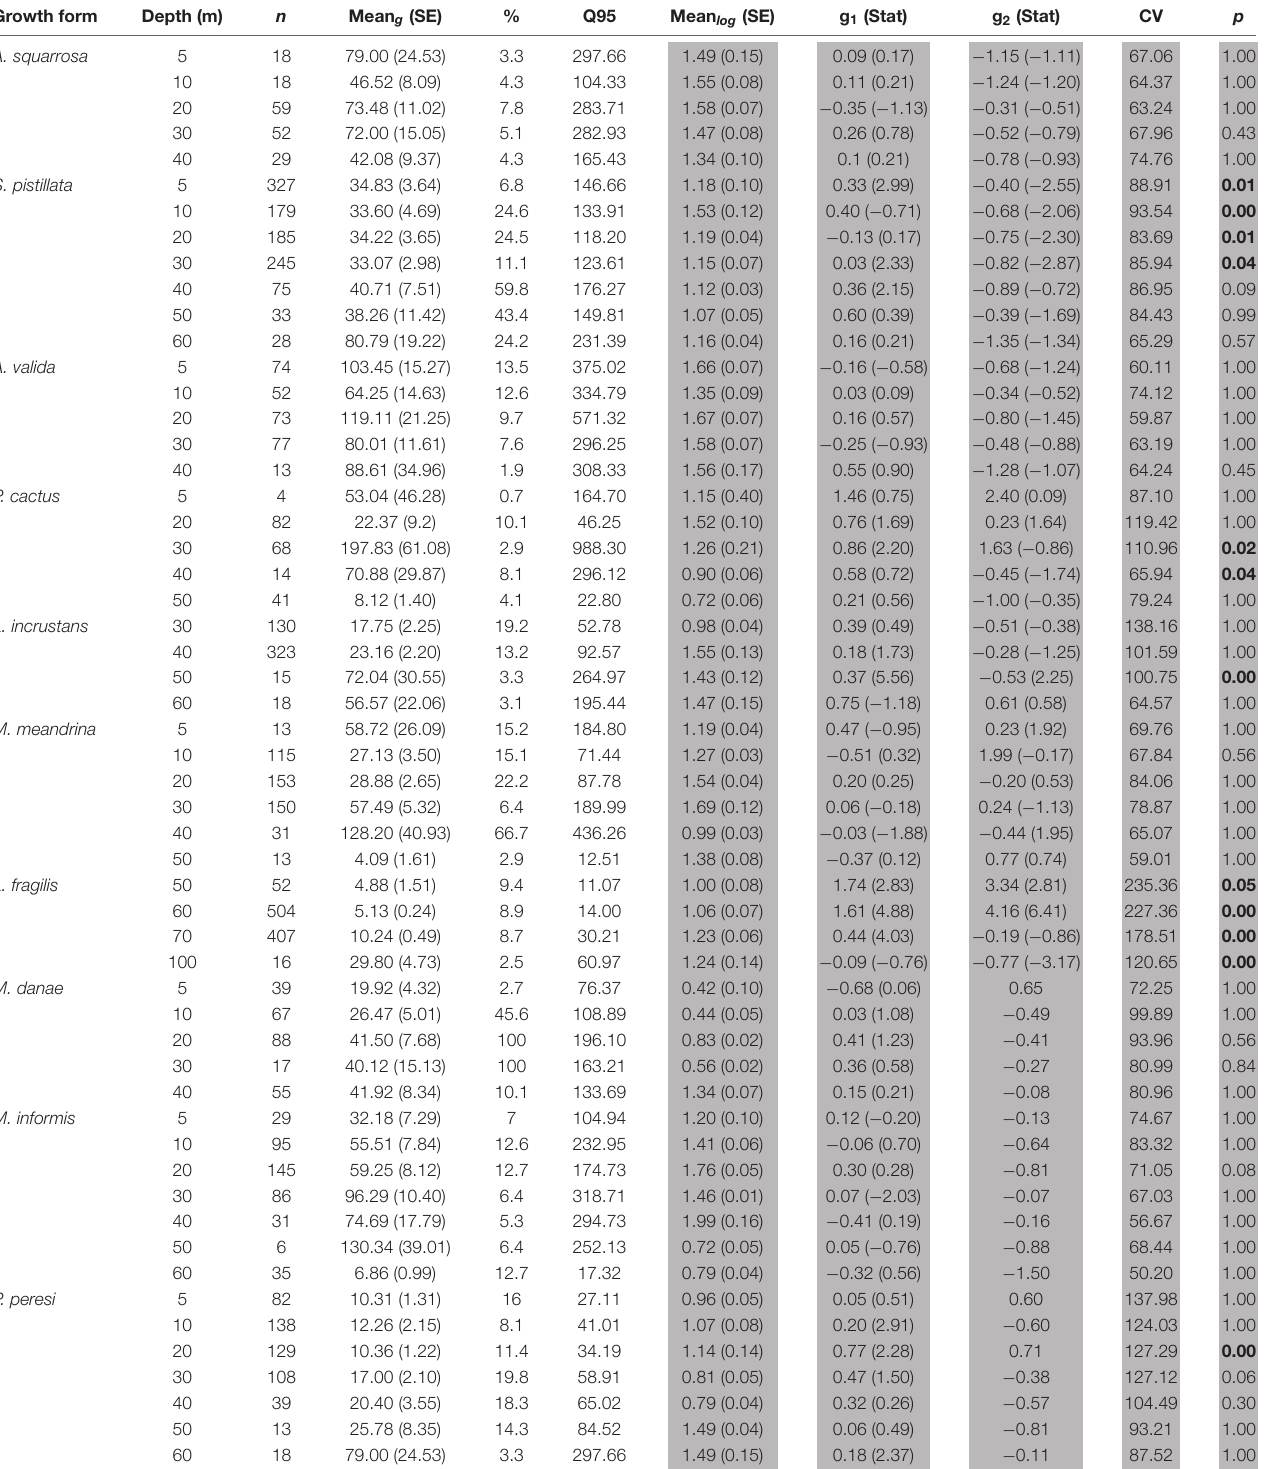
TABLE 2 | Basic statistical summary of untransformed data (white background) and statistical summary of SFD log-transformed colony size (shaded background) based on ten representative species (ordered by growth forms). Growth